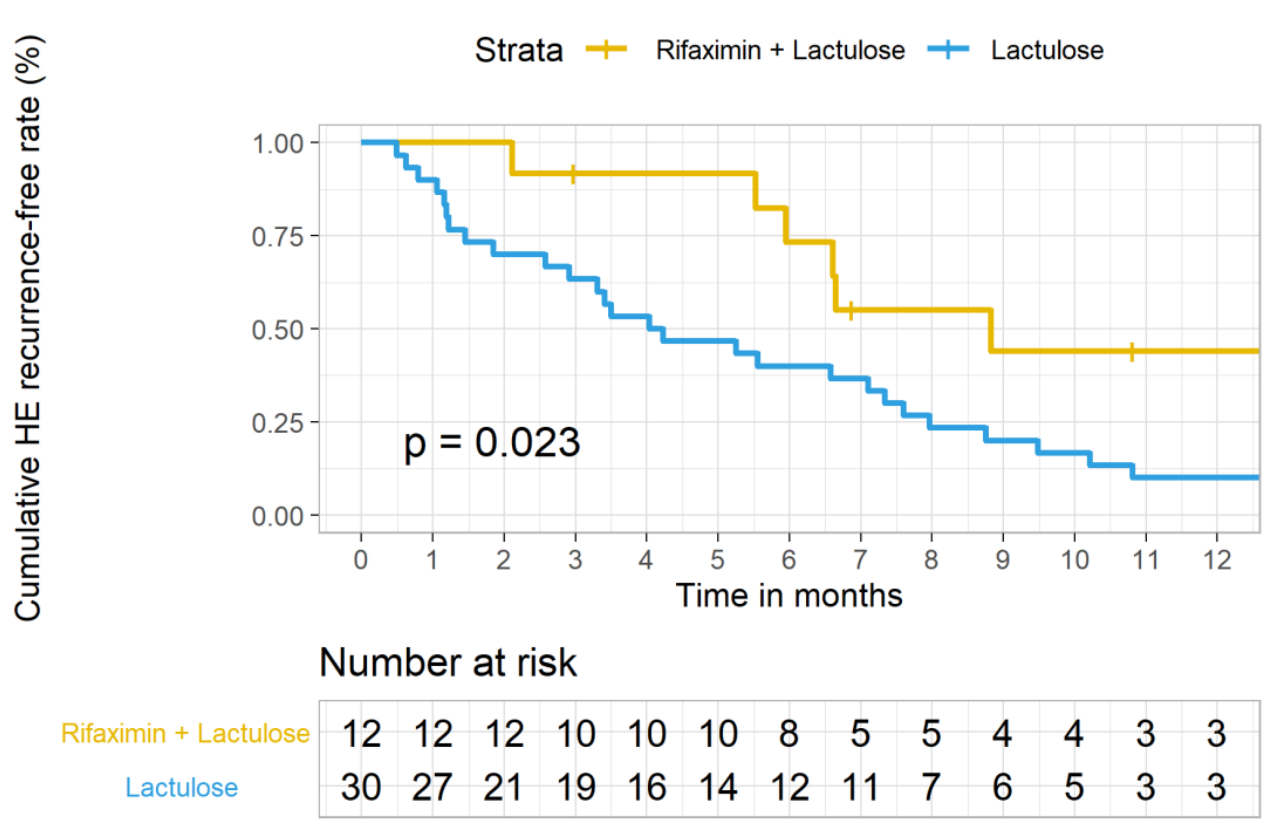
Table 2. Logistic regression estimates of baseline parameters for predicting HE recurrence within 1 year. Univariable Logistic Reg. Multivariable Logistic reg.